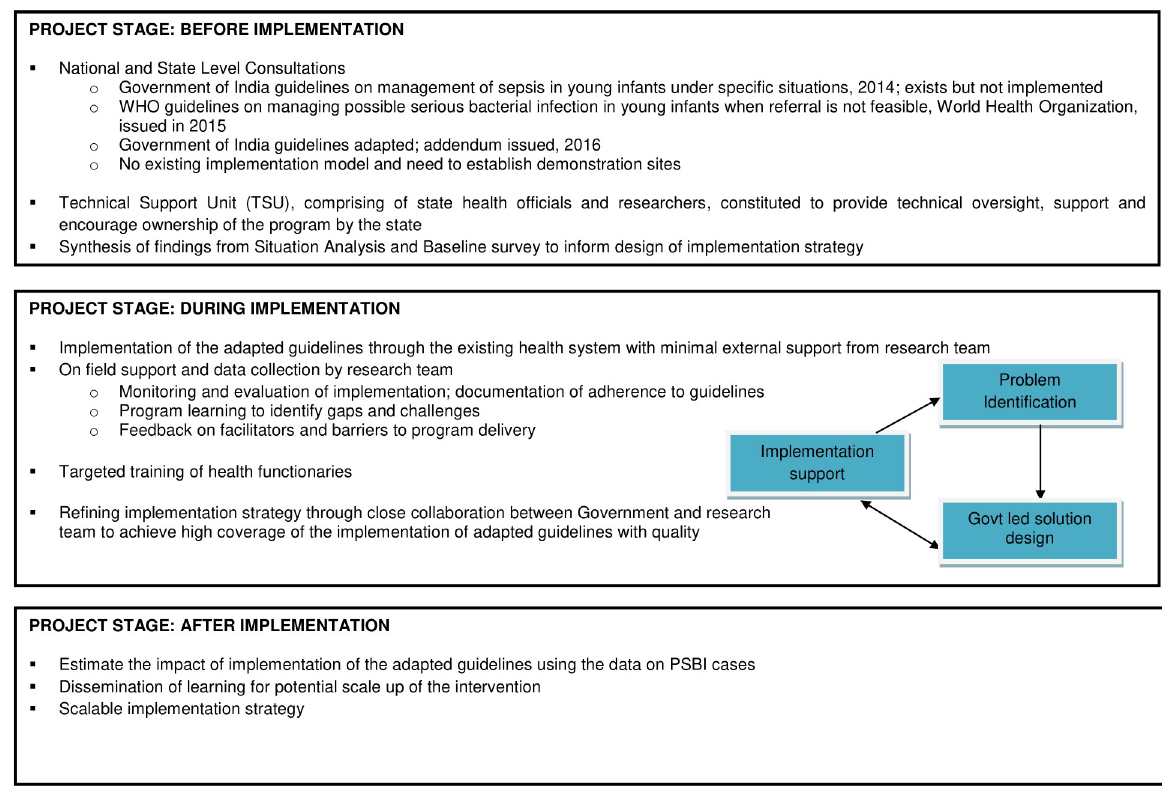
Fig 1. Conceptual framework for implementing the guidelines on management of PSBI, when referral is not feasible, through the public health system in Sirmaur, Himachal Pradesh (adapted from RE-AIM framework) .